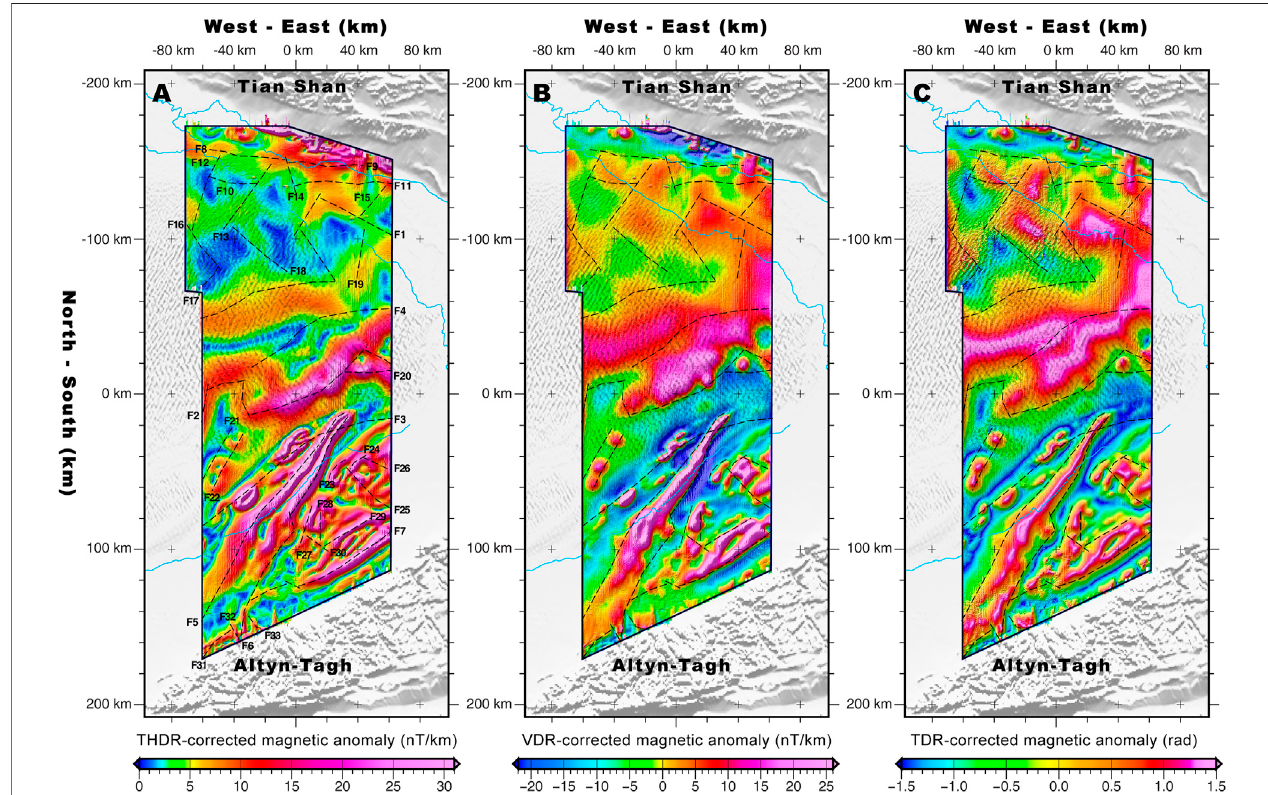
FIGURE 5 | The results of magnetic gradient-processing methods for aeromagnetic anomalies (RTP) with superimposed locations of basement faults. (A) Total horizontal derivative (THDR), (B) vertical derivative (VDR), (C) tilt-derivative (TDR). The dotted lines are the locations of basement faults and the marks of basement faults are shown in (A) . Primary faults are F1: Tadong North Fault, F2: Tadong South Fault, F3: Cherchen Fault. Secondary faults are not